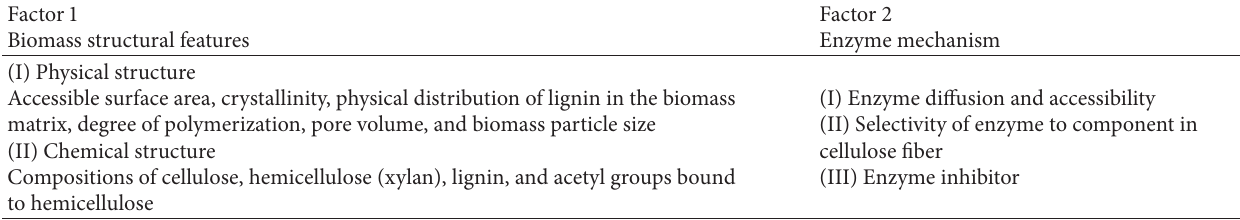
Table 5: Factors that limit hydrolytic efficiency of cellulase on cellulose surface.